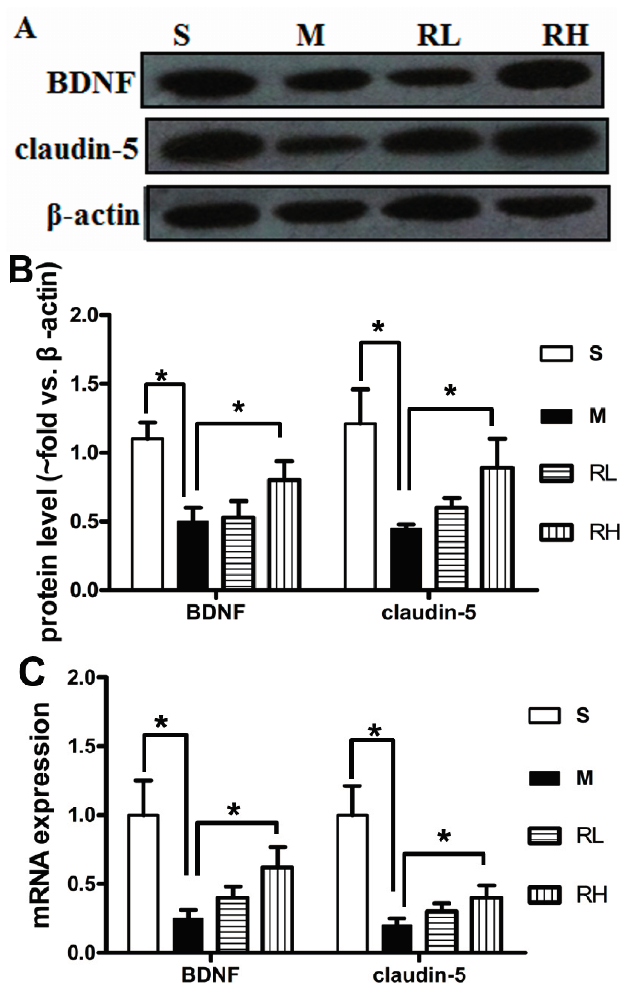
Figure 4. Effect of Rhy on the expression of claudin-5 and BDNF. ( A ). Expression of claudin-5 and BDNF at 24 h after pMCAO in Sham (S), pMCAO (M), Rhy-L (RL), Rhy-H (RH) groups. ( B ). Densitometry analysis. ( C ). The mRNA expressions of claudin-5 and BDNF were measured in Sham (S), pMCAO (M), Rhy-L (RL), Rhy-H (RH) groups ( * p < 0.05 vs.